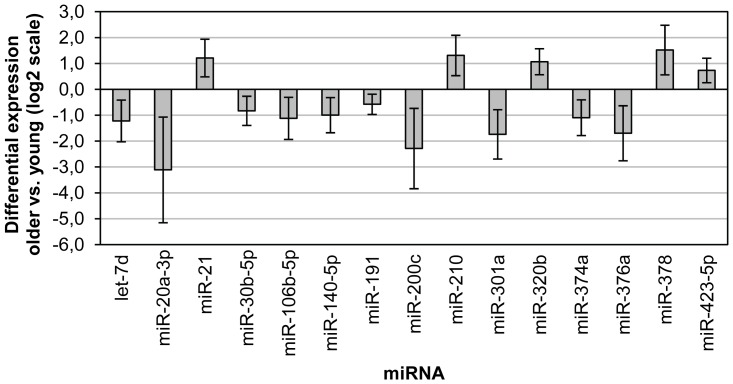
Differential expression of the top-15 ranking miRNAs from the panel screening.The selected miRNAs are displayed in numerical order. Bars represent the difference in expression in older compared to young patients on a 2-logarithmic scale, with indication of the 95% confidence interval (based on t-test).